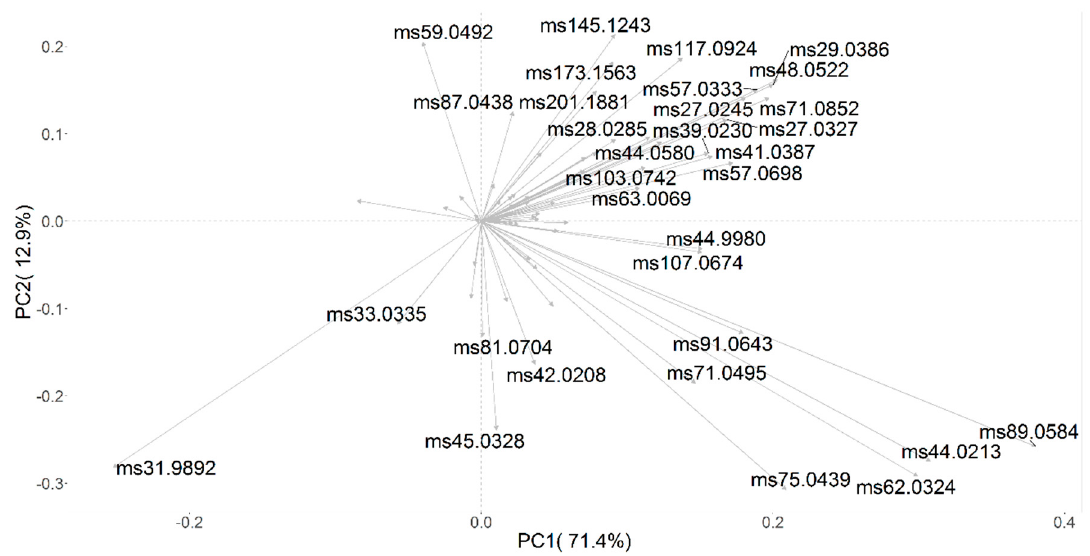
Figure 3. Loading plot of principal component analysis of the mass peaks (ms) related to the observed evolution of VOCs profile in Figure 2. For a detailed view of the figure, the original image is included in the Supplementary Materials (Figure S2).